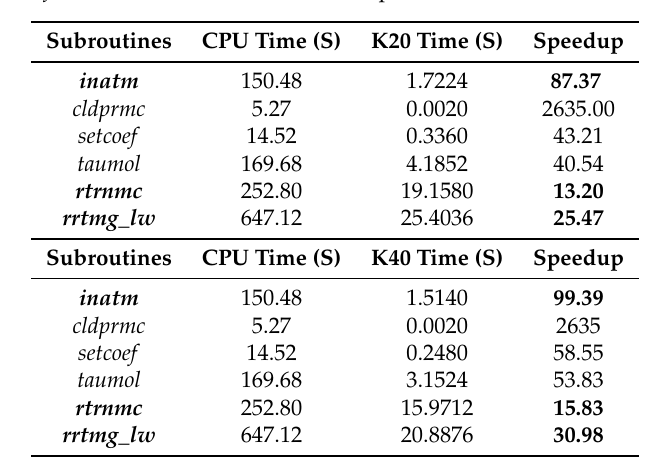
Table 4. Runtime and speedup of the G-RRTMG_LW on one GPU. Here, the block size = 512 and ncol = 2048; inatm and rtrnmc are with an acceleration in the g - point dimension; cldprmc is with a 1D decomposition; setcoef and taumol are with a 2D decomposition.